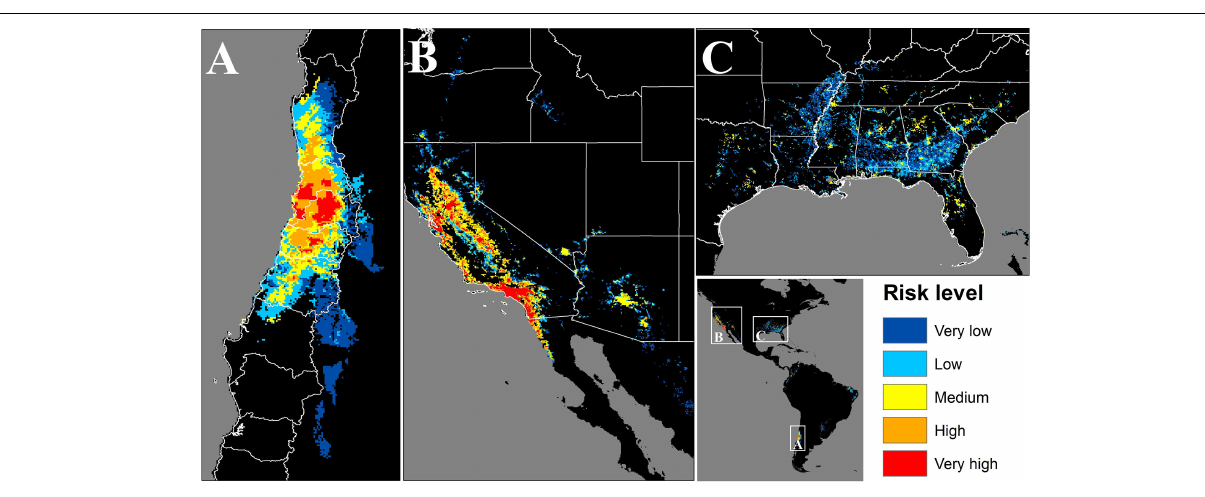
FIGURE 4 | Map of the areas where population could be potentially exposed to a significant risk of contact with C. bacillisporus in Chile (A) , Western United States (B) , and Eastern United States (C) . CQ = Coquimbo, VP = Valparaiso, ST = Santiago Metropolitan region, OH = Libertador Bernardo O’Higgins, MA = Maule, BB = Biobío, CA = California, NV = Nevada, OR = Oregon, WS = Washington, CO = Colorado, ID = Idaho, AZ = Arizona, TX = Texas, LA = Louisiana, AR = Arkansas, MO = Missouri, MS = Mississippi, AL = Alabama, GA = Georgia, FL = Florida, TN = Tennessee, NC = North Carolina, SC = South